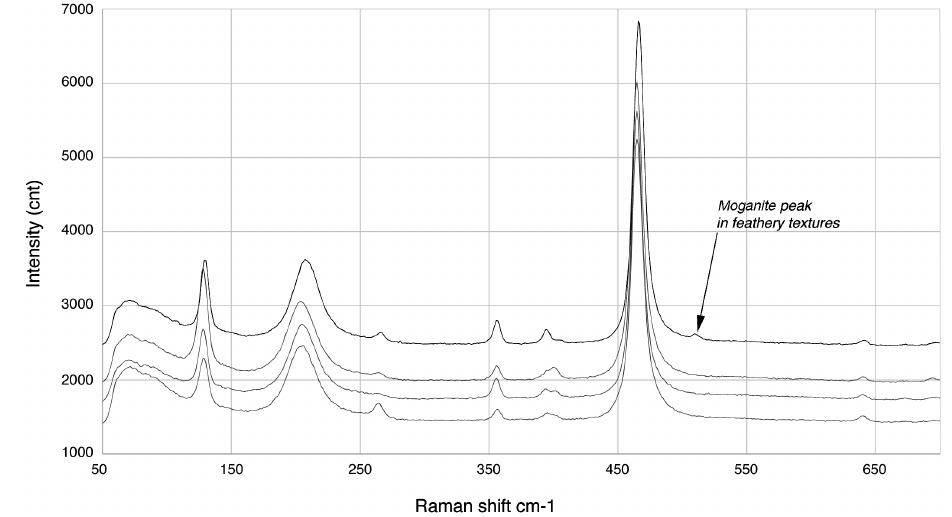
Figure 10. Raman bands of SiO 2 samples from the Rusey Fault Zone: representative Raman spectrum from feathery textures from a quartz coating in the Rusey Fault Zone showing a peak at ∼ 507cm − 1 (dark Raman spectrum); Raman spectra from euhedral quartz from a quartz coating in the Rusey Fault Zone showing no peak at ∼ 507cm − 1 (grey